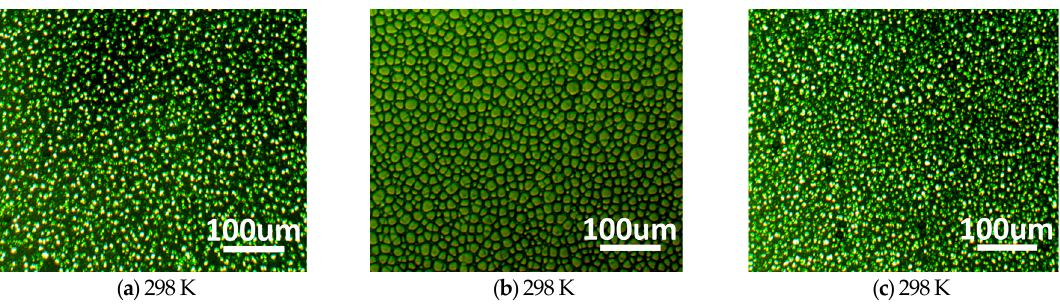
Figure 2. Transmission image of ( a ) the original PS-SPLC; ( b ) the polymer template; and ( c ) the templates with refilling nematic LC.